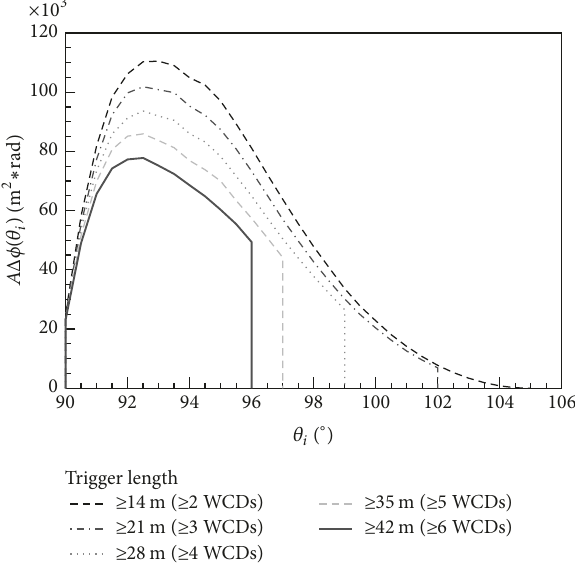
Figure 8: Values of the differential effective area as a function of the polar angle 𝜃 𝑖 measured from zenith (the horizontal orientation, parallel to the 𝑦 󸀠 axis, for the vectors is at 90 ∘ ). The results are shown for different trigger